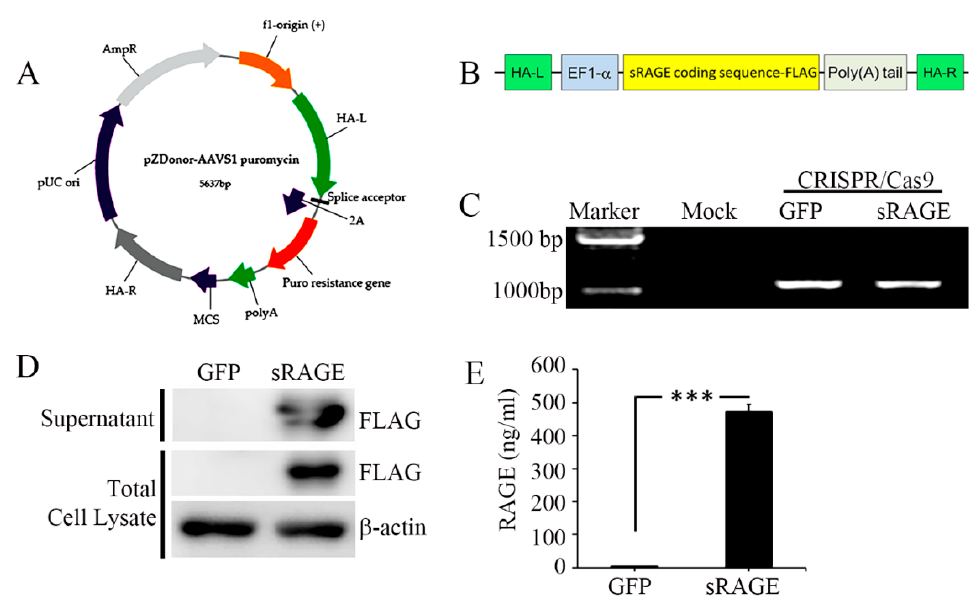
Figure 6. sRAGE-secreting MSC line characterization. ( A ) The illustration picture represents the gene information of pZDonor-AAVS1 puromycin vector. Each arrow describes a certain gene. ( B ) The illustration of sRAGE insertion coding sequence. ( C ) Genome integration was confirmed with genomic DNAs of MSCs which were transfected with mock, GFP, and sRAGE-containing pZDonor- AAVS1 plasmids. ( D ) Western blot analysis of supernatant and extract from MSCs transfected with GFP (lane 1) and FLAG-tagged sRAGE in pZDonor-AAVS1 vector (lane 2). β -actin loaded as a positive control. ( E ) The secretion of human sRAGE levels was confirmed with ELISA after puromycin selection; and statistical analysis was performed using Student’s t -test; ***, p < 0.001.